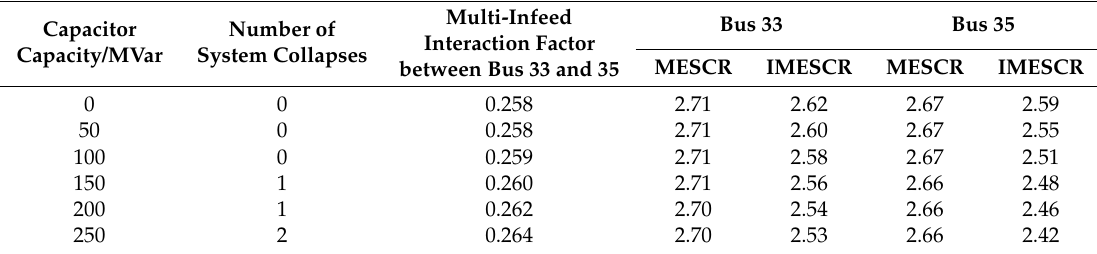
Table 2. Multi-infeed effective short circuit ratio and improved multi-infeed effective short circuit ratio of the DC inverter buses under different shunt capacitor